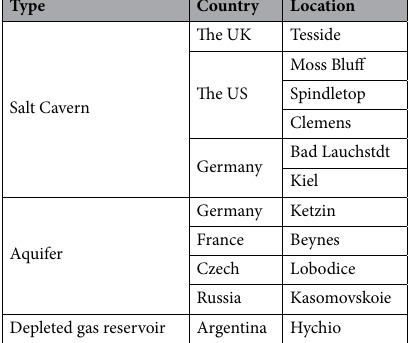
Table 1. Worldwide underground hydrogen storage projects 2,15 . More information is provided in the supplementary